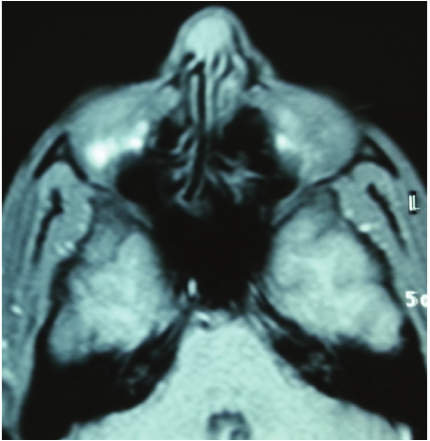
Figure 3: Cystic mass in T2-weighted cranial MRI on the right side of the nasal dorsum.